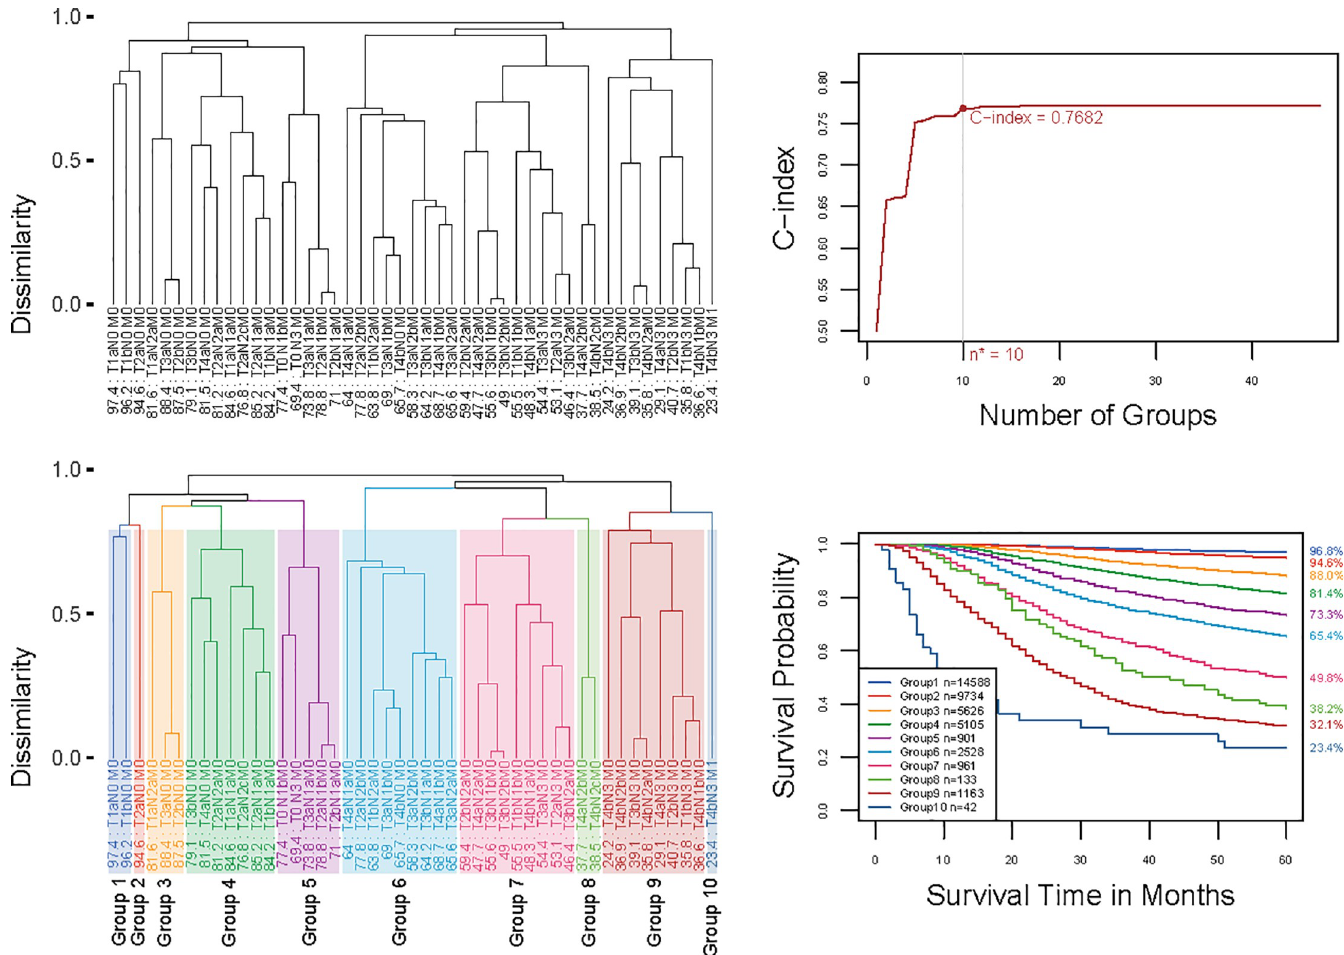
Fig 2. Creating EACCD prognostic groups on T, N, and M by the training set. A Dendrogram from running EACCD. A 5-year melanoma-specific survival rate in percentage is provided below each combination. B C-index curve based on the dendrogram in panel A . The knee point of the curve corresponds to 10 groups and a C- index value of 0.7682. C Cutting the dendrogram in panel A according to n � = 10 suggested in panel B creates 10 prognostic groups, shown in rectangles. Listed on the bottom of the dendrogram are group numbers. D Melanoma-specific survival of 10 prognostic groups in panel C . The 5-year melanoma-specific survival rates for 10 groups are listed on the right side of the